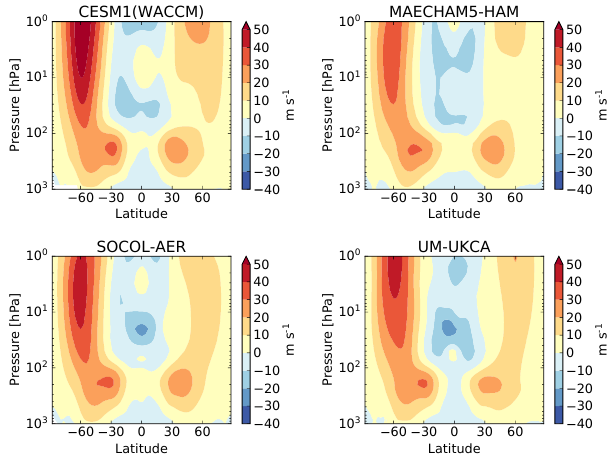
Figure 12. Zonal mean zonal wind (ms − 1 ) averaged over the first year after the eruption (April 1815–April 1816) in each model simulation (ensemble mean). Zonal wind is output on 36 pres- sure levels in UM-UKCA, 33 pressure levels in MAECHAM5- HAM and 32 pressure levels in SOCOL-AER. Zonal wind in CESM1(WACCM) is output on an atmosphere hybrid sigma- pressure coordinate and has been interpolated to the pressure levels used in